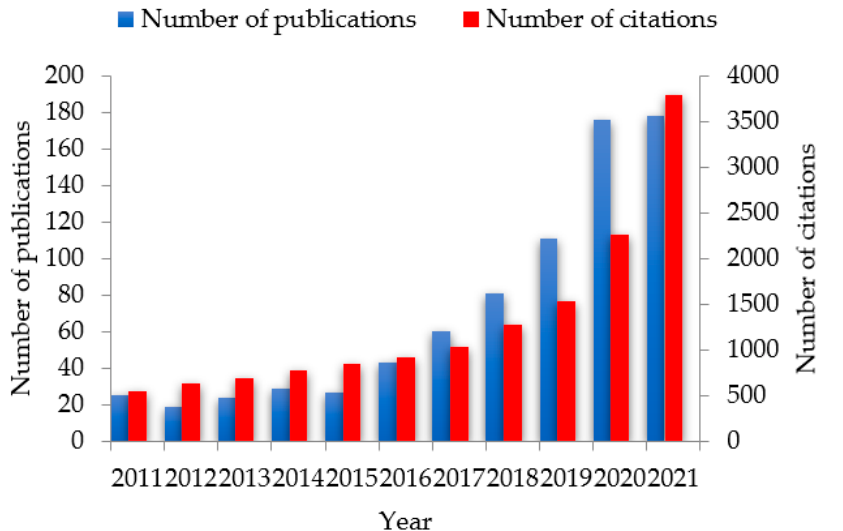
Figure 1. Number of publications and citations per year (search query was performed on 18 May 2022) on application of Industry 4.0 in the food industry over the last decade. The following keyword search query was used in Scopus: TITLE-ABS-KEY (Fourth industrial revolution) OR (Industry 4.0) AND (Food industry).